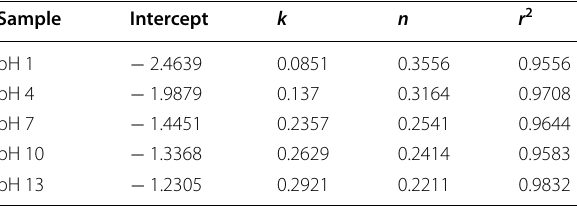
Table 1 Diffusion parameters of the 50/50 CS/PVA hydrogel at different pH values